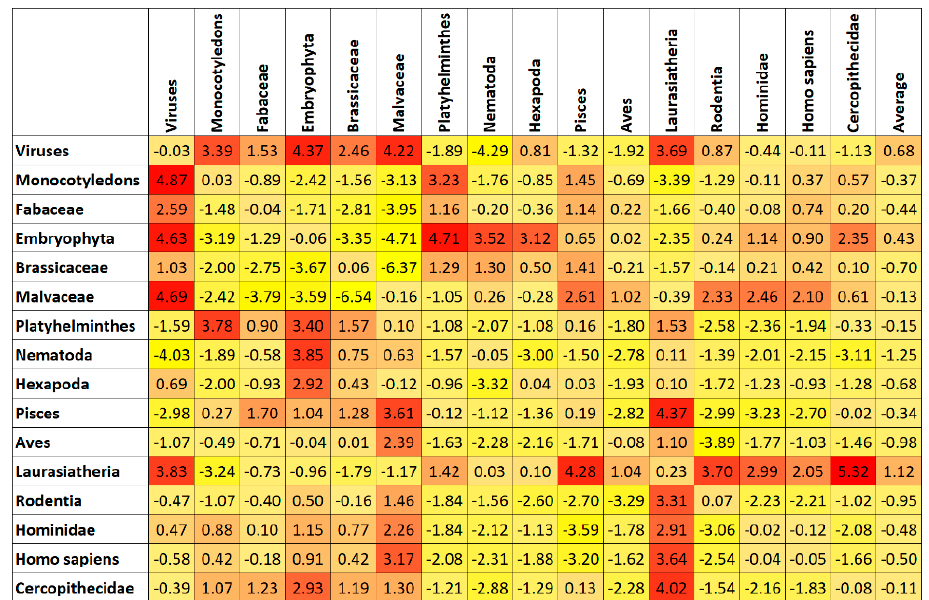
Figure 5. Results in the figure stem from k-mer first–last distance features only. Average accuracy for 100-fold MCCV using a random forest classifier and a split of 80% training and 20% testing. Yellow shades refer to lower accuracy, while red shades indicate higher average classification accuracy.